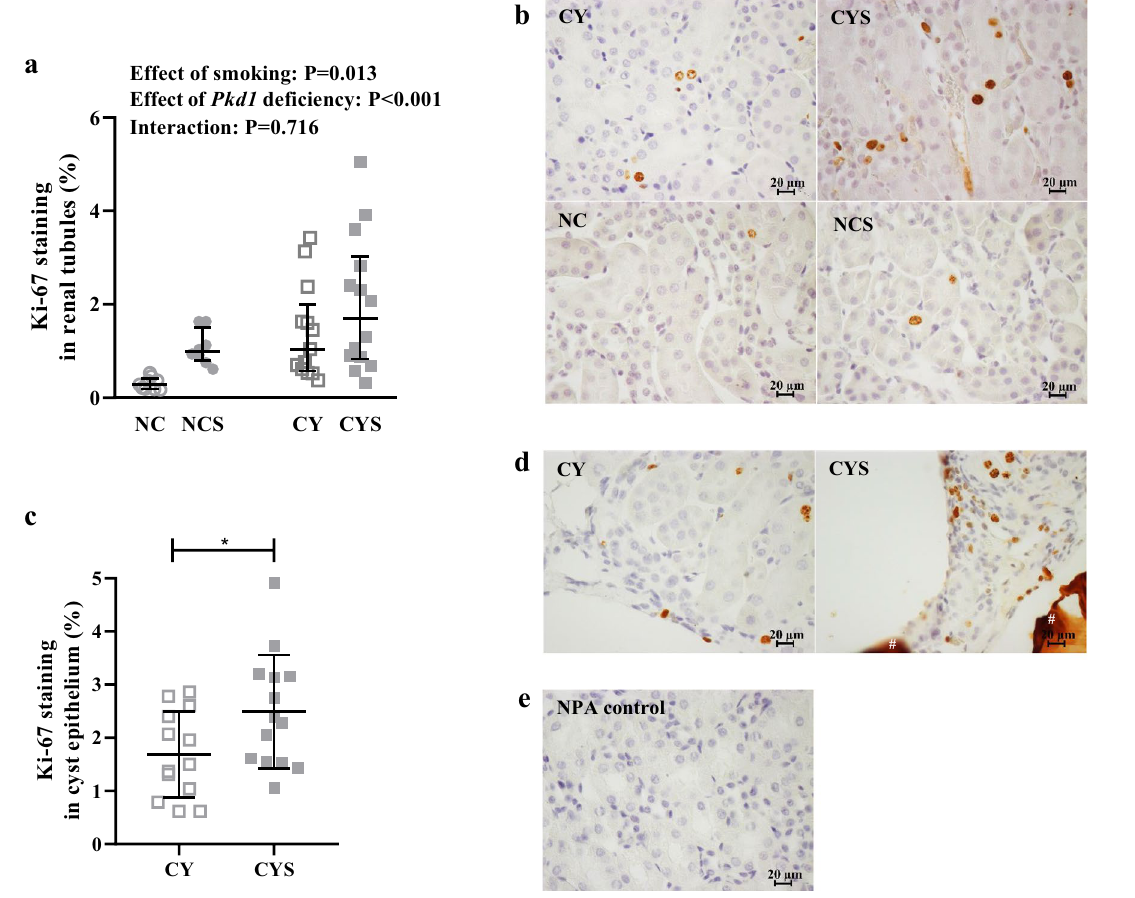
Figure 4. ( a ) Analysis of the effects of smoking and Pkd1 deficiency in tubular epithelial cell proliferation on NC (n = 9), NCS (n = 8), CY (n = 13) and CYS (n = 14) mice. This analysis was carried out using aligned rank transform followed by two-way analysis of variance. ( c ) Comparative analysis of cell proliferation in renal cystic epithelium between CY (n = 13) and CYS (n = 14) animals. This comparison was performed using unpaired t-test. *P < 0.05. ( b , d ) Representative images of Ki-67 staining in renal tubular epithelium and cystic epithelium, respectively. # Extracellular protein aggregate non-specifically stained. ( e ) Negative control without primary antibody (NPA control) corresponding to the Ki-67 staining images shown in b and d. ( b , d , e ): Original magnification, × 400; bar = 20